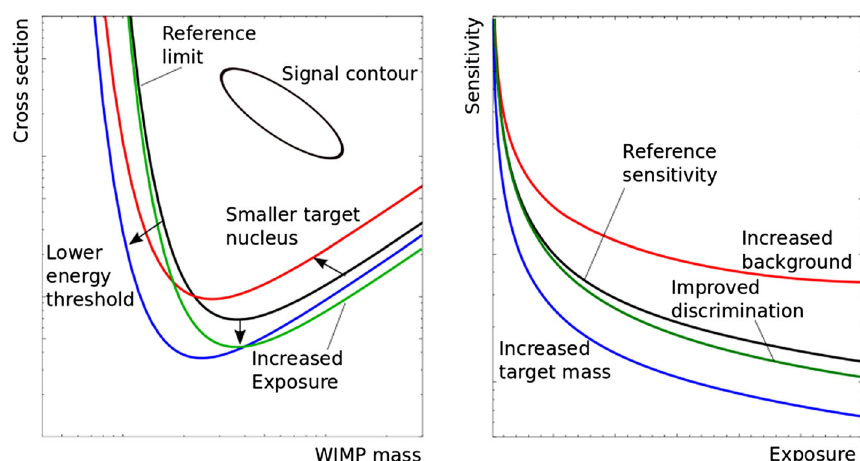
Fig. 3 Left Illustrative impact of the energy threshold, exposure and target nucleus. Right Impact of background and exposure on the sensitivity. These plots are taken from Ref.